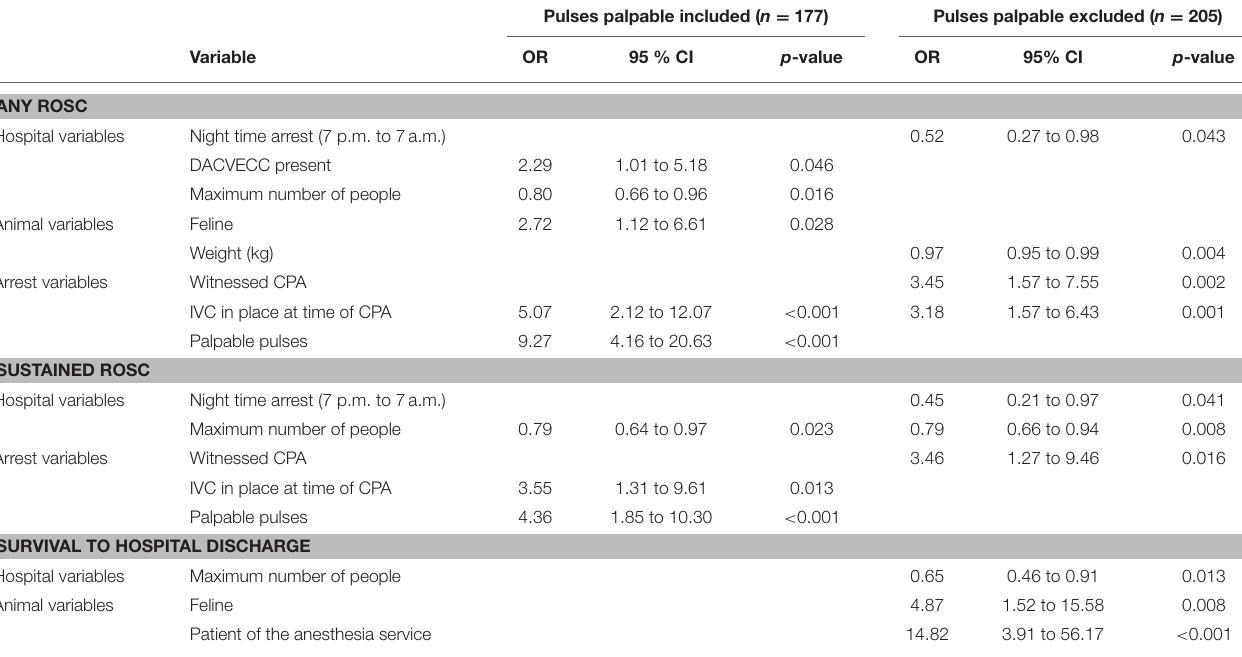
TABLE 1 | Significant results of multivariable linear regression analyses for the three outcomes of interest, any return of spontaneous circulation (ROSC), sustained ROSC, and survival to hospital discharge in 172 dogs and 47